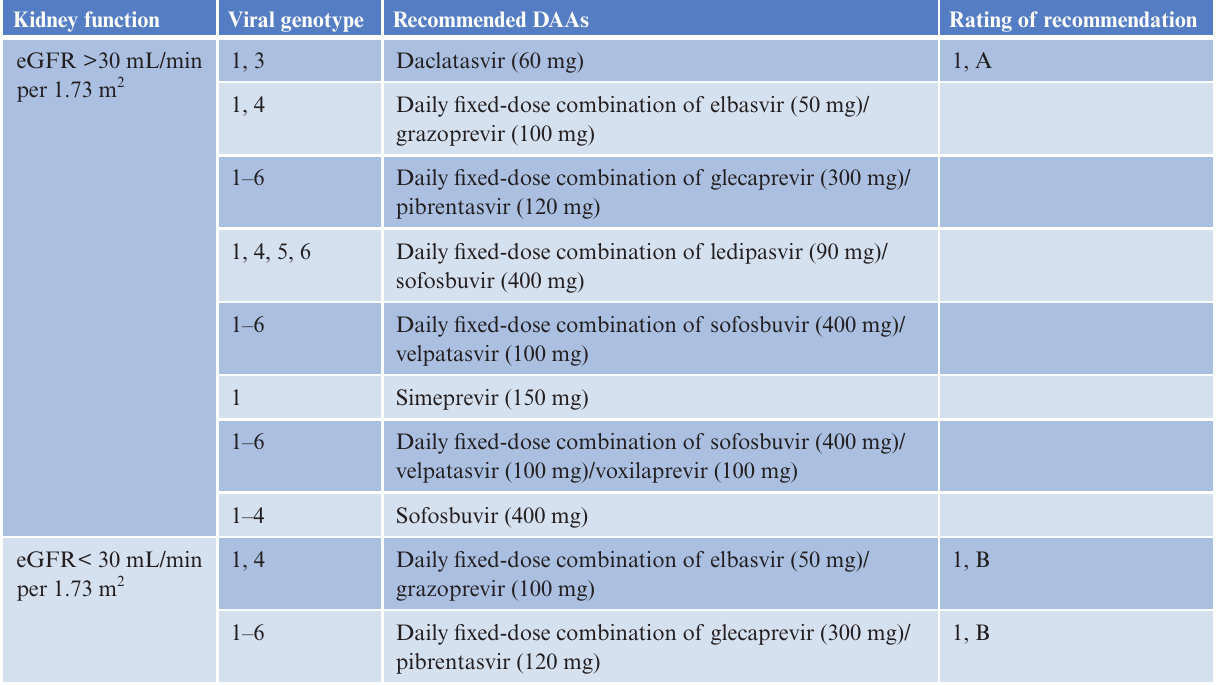
Table 4. Recommended direct-acting therapies by eGFR and viral genotype (AASLD/IDSA) (6) Kidney function Viral genotype Recommended DAAs Rating of